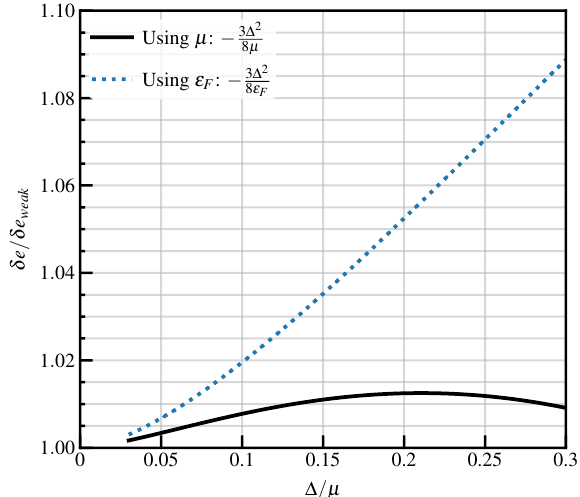
Figure A1. Solid black line shows the ratio of the weak-coupling approximation for δ(cid:101) (Equation (A7)) to the exact result (Equation (A6)). The blue dotted line shows the same, but with µ in Equation (A7) replaced by ε F